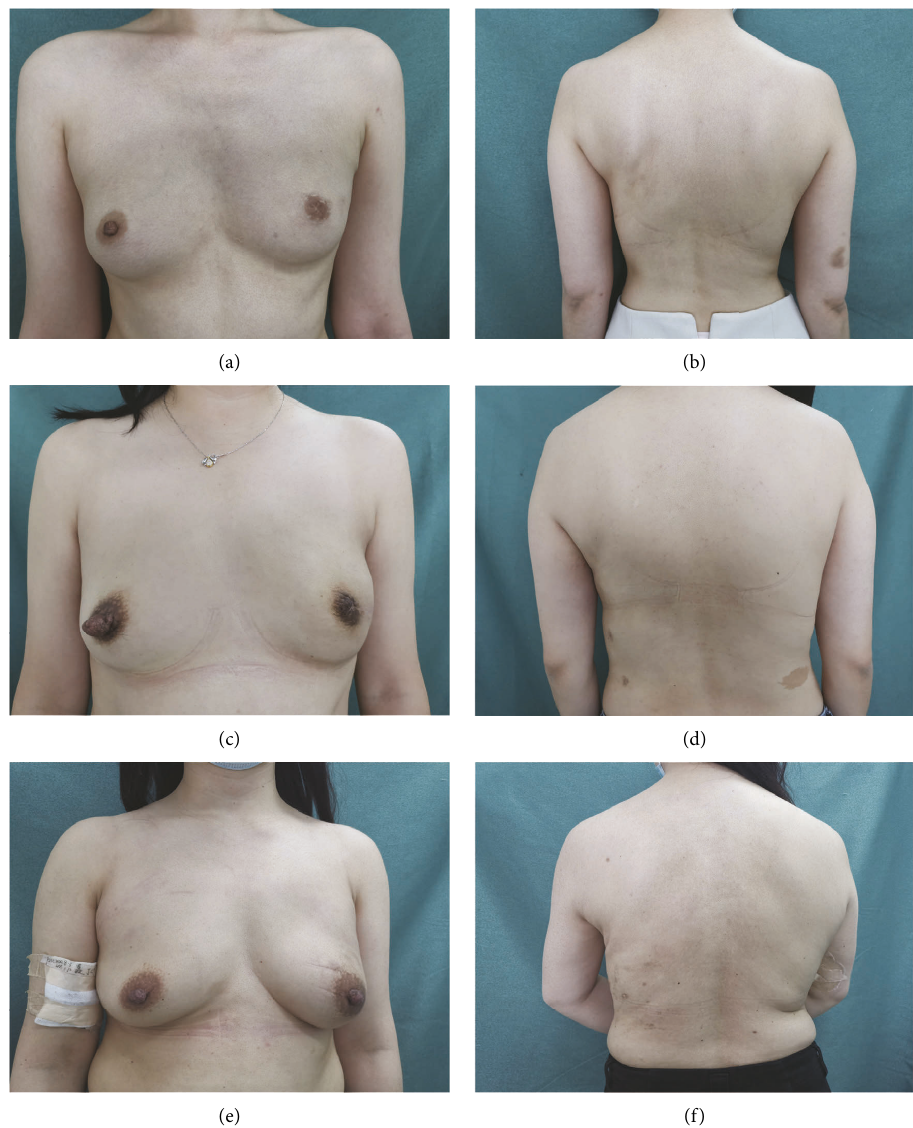
Figure 5: (a-b) Photos of a 34-year-old woman with her left breast undergoing E-SSM and E-LDMF harvesting followed by LDMF breast reconstruction 18 months after the operation. (c-d) Photographs of a 32-year-old woman 7 months after the LDMF breast reconstruction following E-SSM. (e-f) Photographs of a 36-year-old woman after E-NSM and LDMF combined with prosthesis breast reconstruction at 6 months